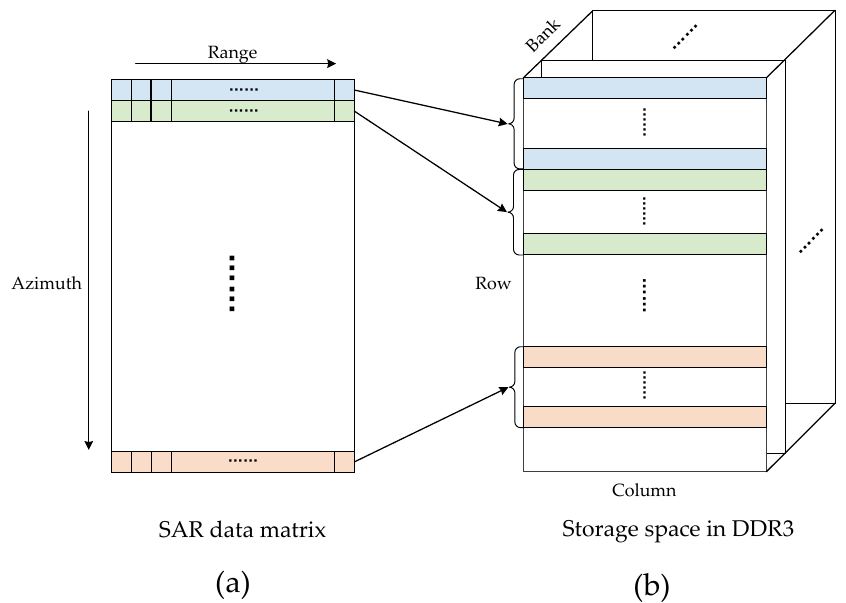
Figure 5. Schematic diagram of conventional SAR data matrix storage method. ( a ) The SAR data matrix; ( b ) each row in the matrix is stored within multiple rows in Double-Data-Rate Three (DDR3) by using the conventional mapping method.